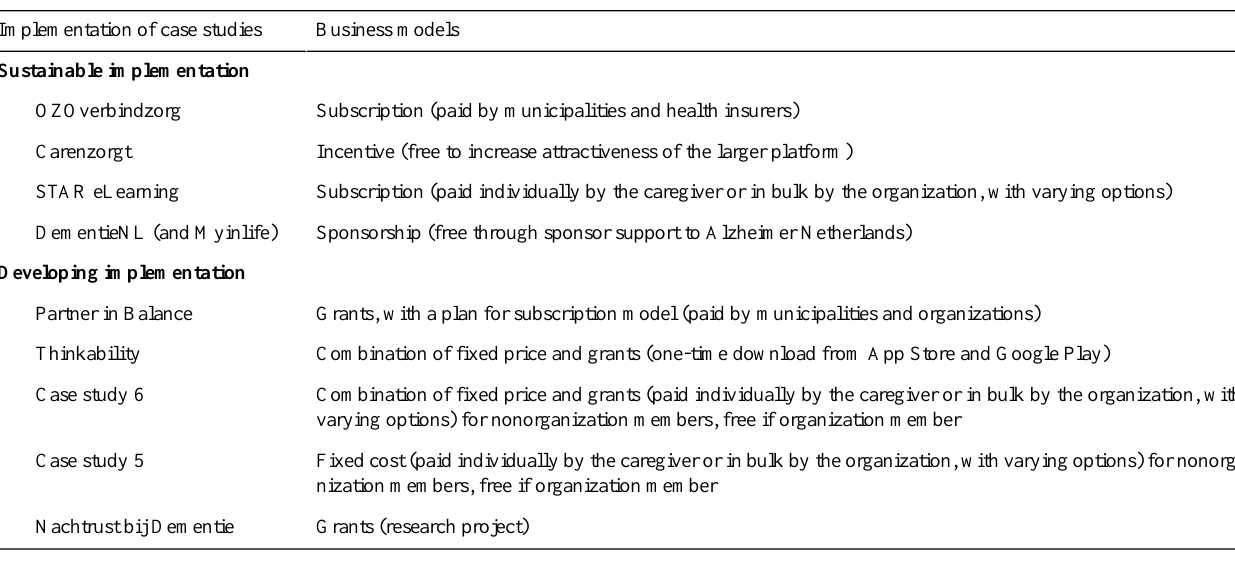
Business modelsImplementation of case studies